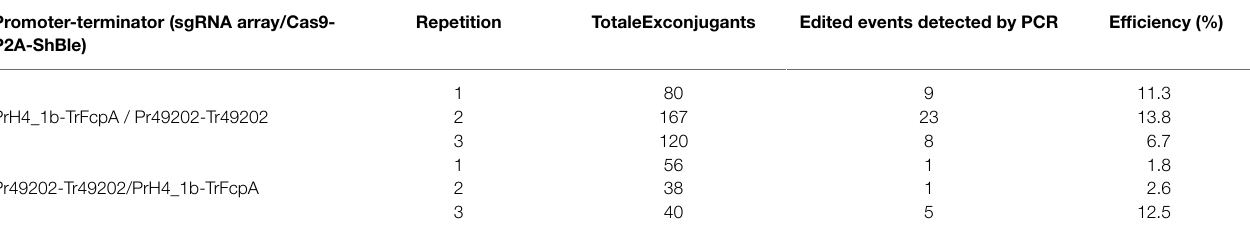
TABLE 2 | Editing efficiency of two episome constructs with orthogonal RNA polymerase II promoters driving gRNA and Cas9 expression to detect deletions in the StLDP gene. Promoter-terminator (sgRNA array/Cas9- P2A-ShBle)